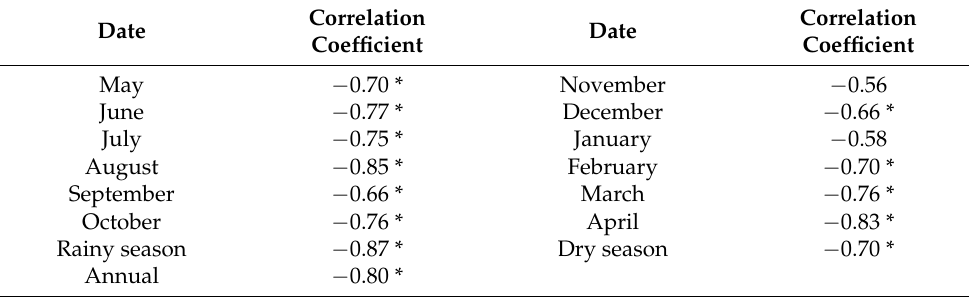
Table 1. The δ 18 O-altitude relationships in